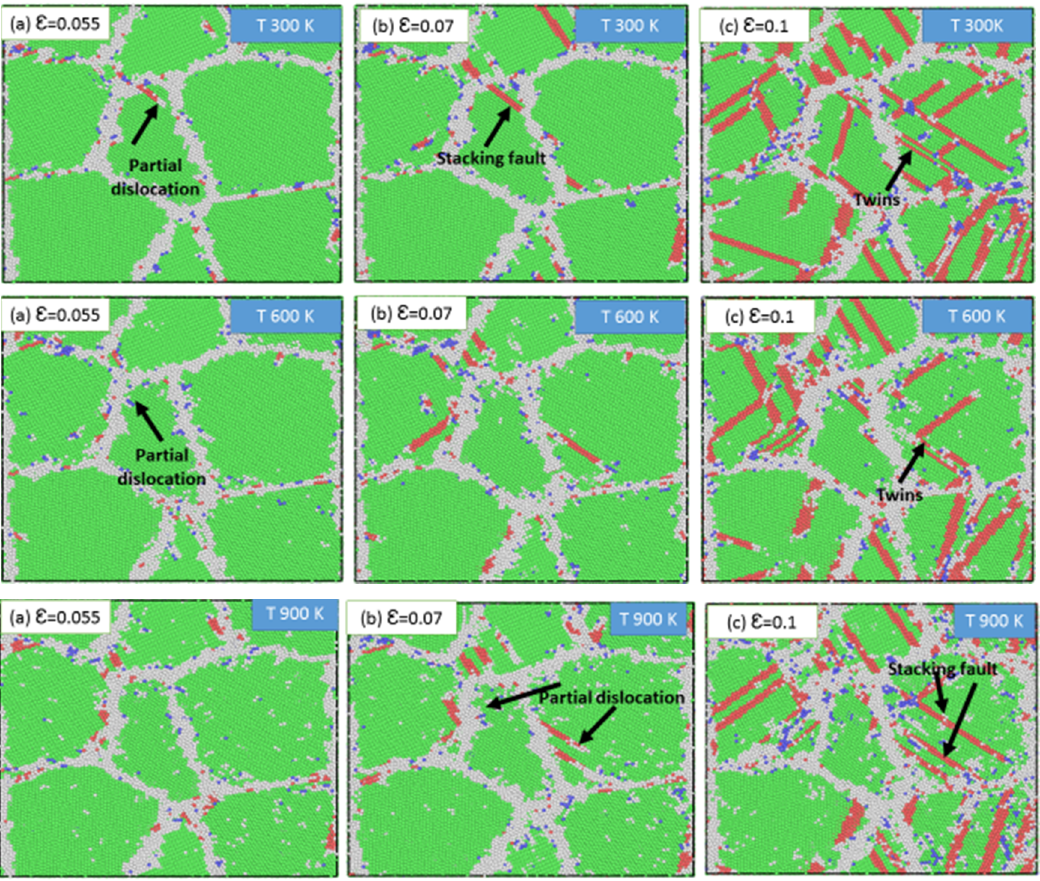
Figure 15. Snapshots of the sample with an average grain size of 7.7 nm at various temperatures 300, 600, and 900 K, and various strain ( a ) ε = 0.055, ( b ) ε = 0.07, and ( c ) ε = 0.1.